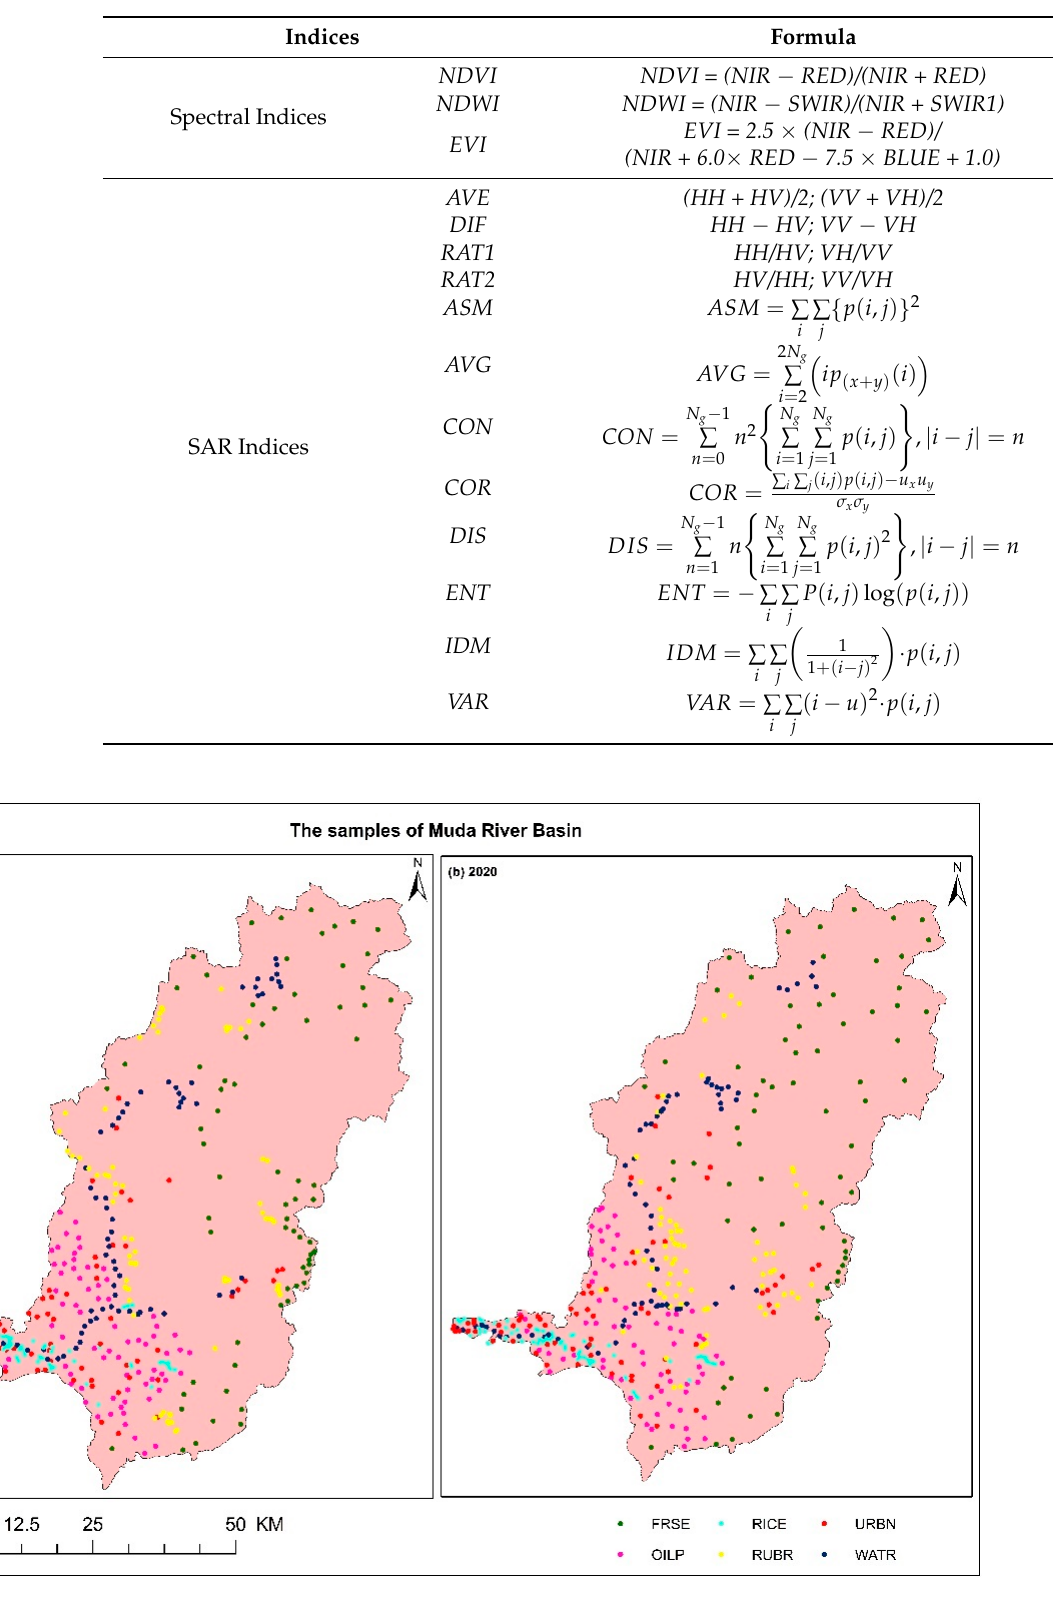
Table 2. Spectral and SAR Indices.